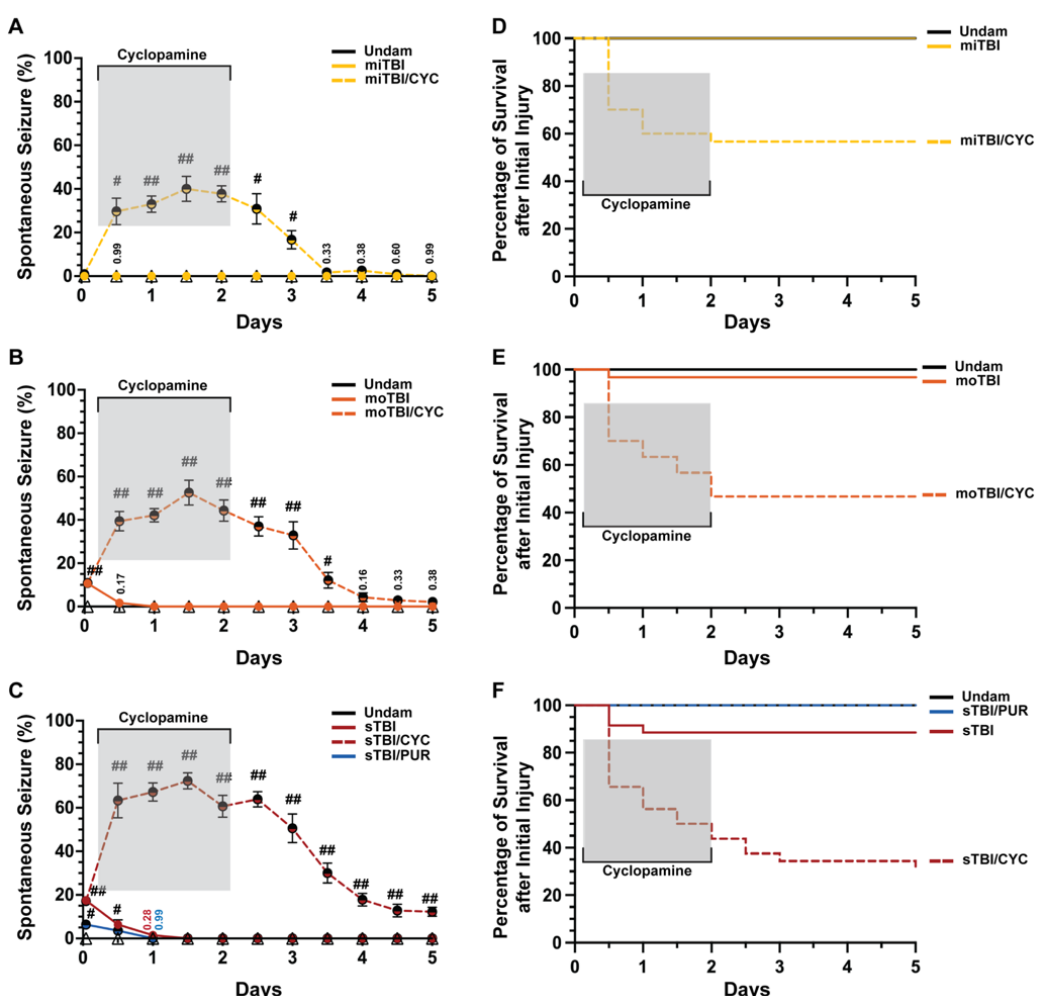
Figure 2. Modulation of Shh alters frequency of TBI-induced PTS events. ( A – C ) Percentage of fish that displayed spontaneous seizure events spanning the timeframe from within 1 hpi to 5 dpi with and without Shh modulation. ( D – F ) Percentage of survival across 5 days of fish who initially survived the primary injury across mi-, mo-, and sTBI with and without Shh modulation. Statistical analyses of the repeated-measures data were performed with the Friedman test, n = 100 fish per control/experimental group, grey box denotes period of cyclopamine administration, # p < 0.05, ## p < 0.01.